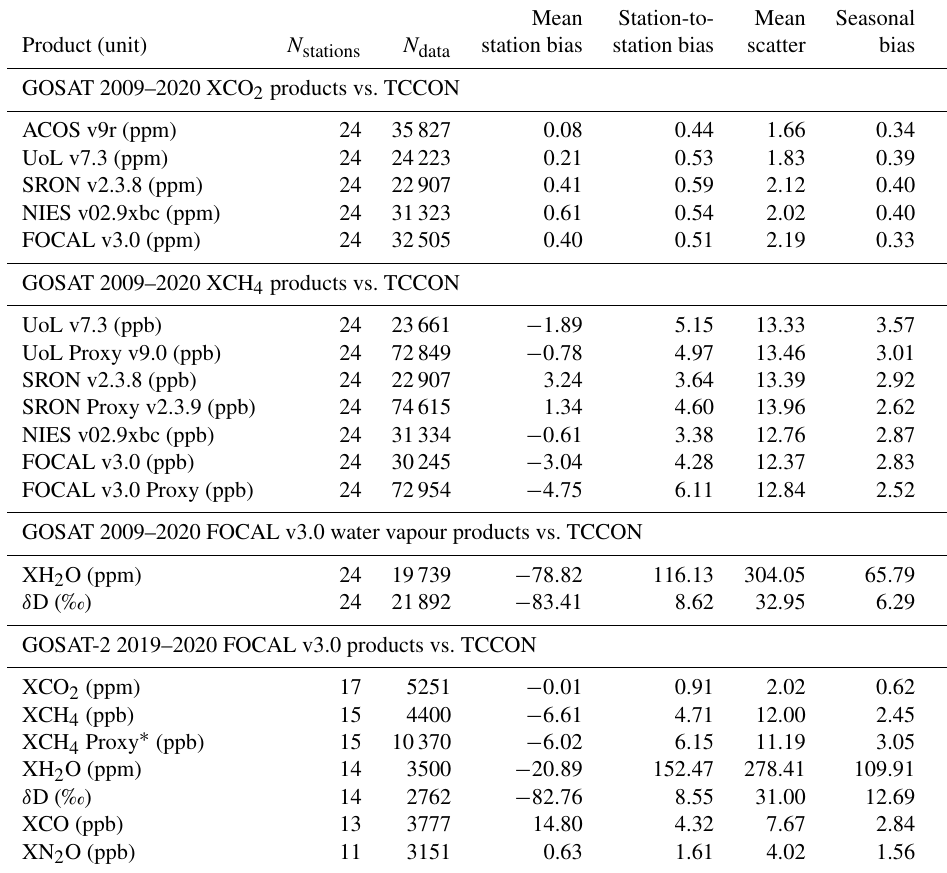
Table 6. Results from TCCON comparisons. N stations denotes the number of TCCON stations involved in the comparison, N data is the number of co-located data points. All products are full-physics products except for those marked as